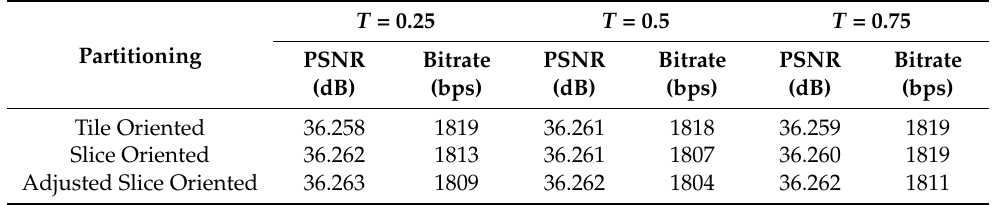
Table 2. PSNR (dB) and bitrate (bps) for different values of T